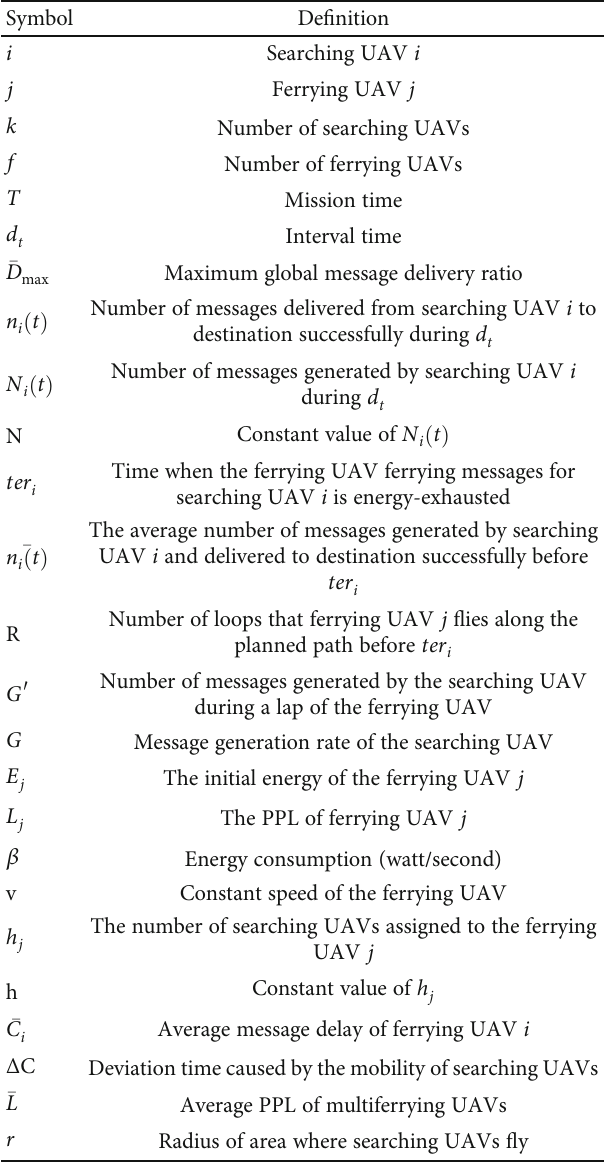
Table 1: Symbols and de fi